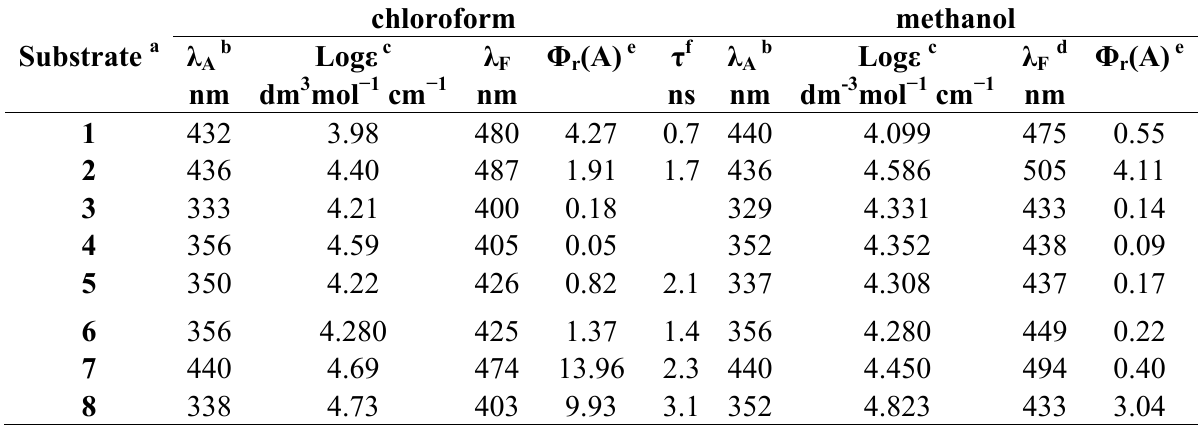
Table 1. Absorption and fluorescence spectra of coumarins 1 - 8 in chloroform and methanol. Substrate